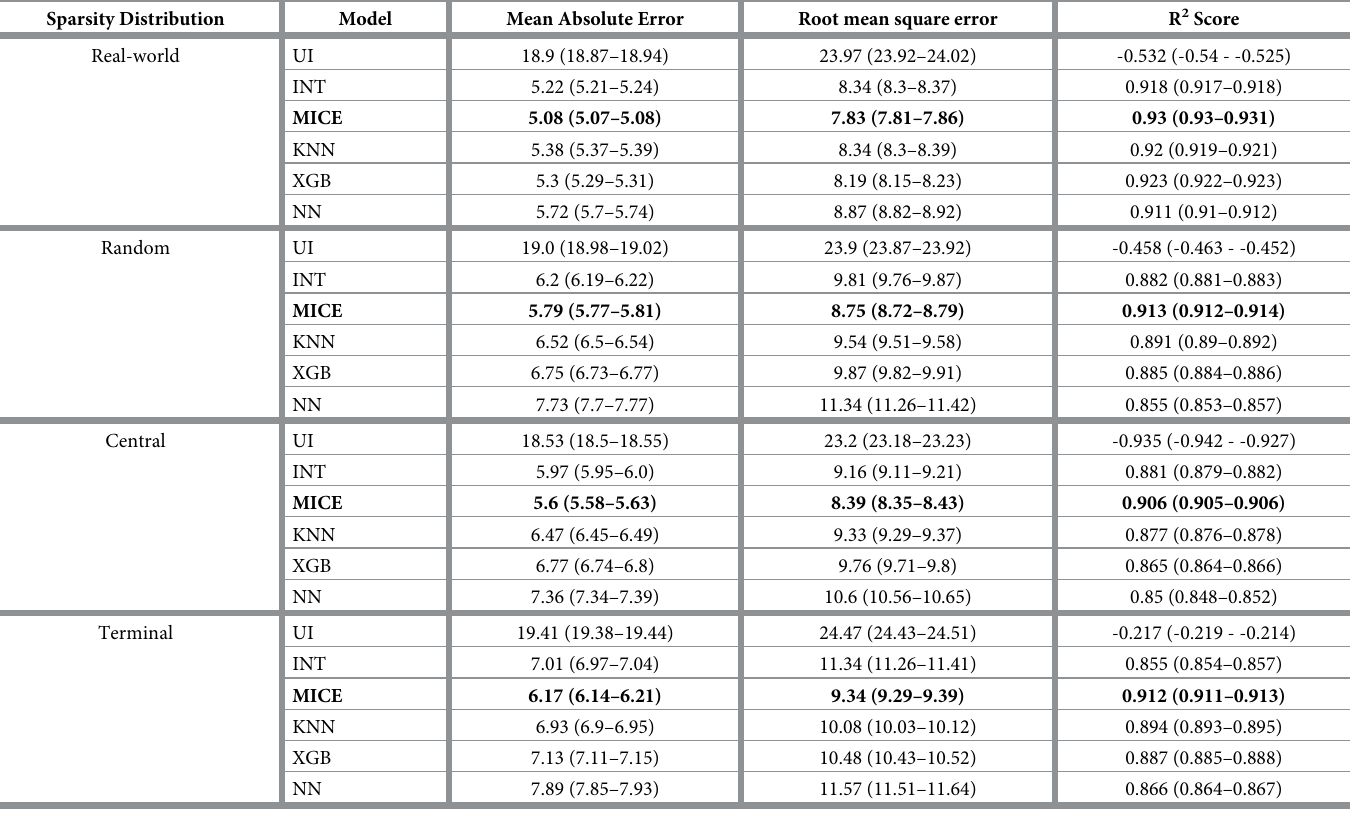
Table 1. Model selection. Model performance assessment given different sparsity distributions. Quantity of missing data varied on a per-instance basis, capped at 6 miss- ing features but otherwise statistically equivalent to parent subset. Results averaged across 10 simulations, reported as mean (95% confidence